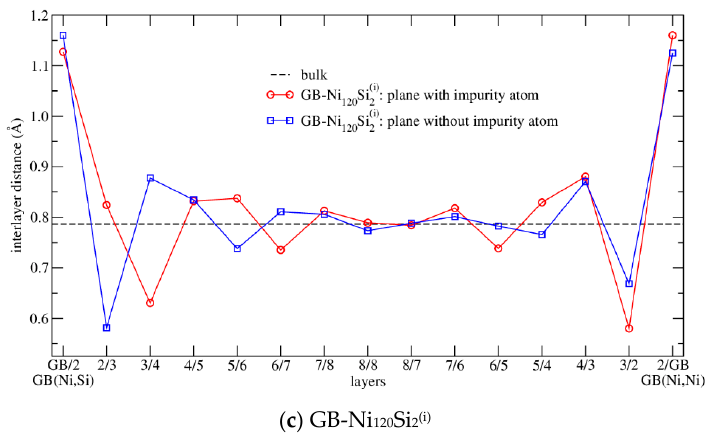
Figure 4. The interlayer distances in supercells with a GB: ( a ) GB-Ni 120 , ( b ) GB-Ni 118 Al 2(s) , ( c ) GB-Ni 120 Si 2(i) . The violet line with diamonds corresponds to a clean GB in elemental fcc Ni. The blue (red) line with squares (circles) characterizes the planes without (with Al or Si) impurity, which are parallel to the plane of paper in structures shown in Figure 3. The exact meaning of expression plane is defined in the text. GB(X,Ni) denotes the GB with impurity X (X = Al (s) , Si (i) ) and GB(Ni,Ni) the clean GB. The lines do not reflect any physical meaning; they are used to guide the eye only. The dashed line corresponds to the interlayer distance in ferromagnetic fcc Ni (this work). For a better demonstration of results in a case of (b) and (c), the plane with impurity atom is always presented so that there is an impurity on the left part of the figures. This was achieved by the shift ½ of the lattice parameter b of lines representing the results of some planes with impurities (the middle plane of GB-Ni 118 Al 2(s) or the second plane of GB-Ni 120 Si 2(i) ) and one without impurity (the middle plane of GB-Ni 120 Si 2(i) ) see Figure 1. This figure does not contain the system GB-Ni 118 Si 2(s) as it provides results similar to data presented for system GB-Ni 118 Al 2(s) in part (b).